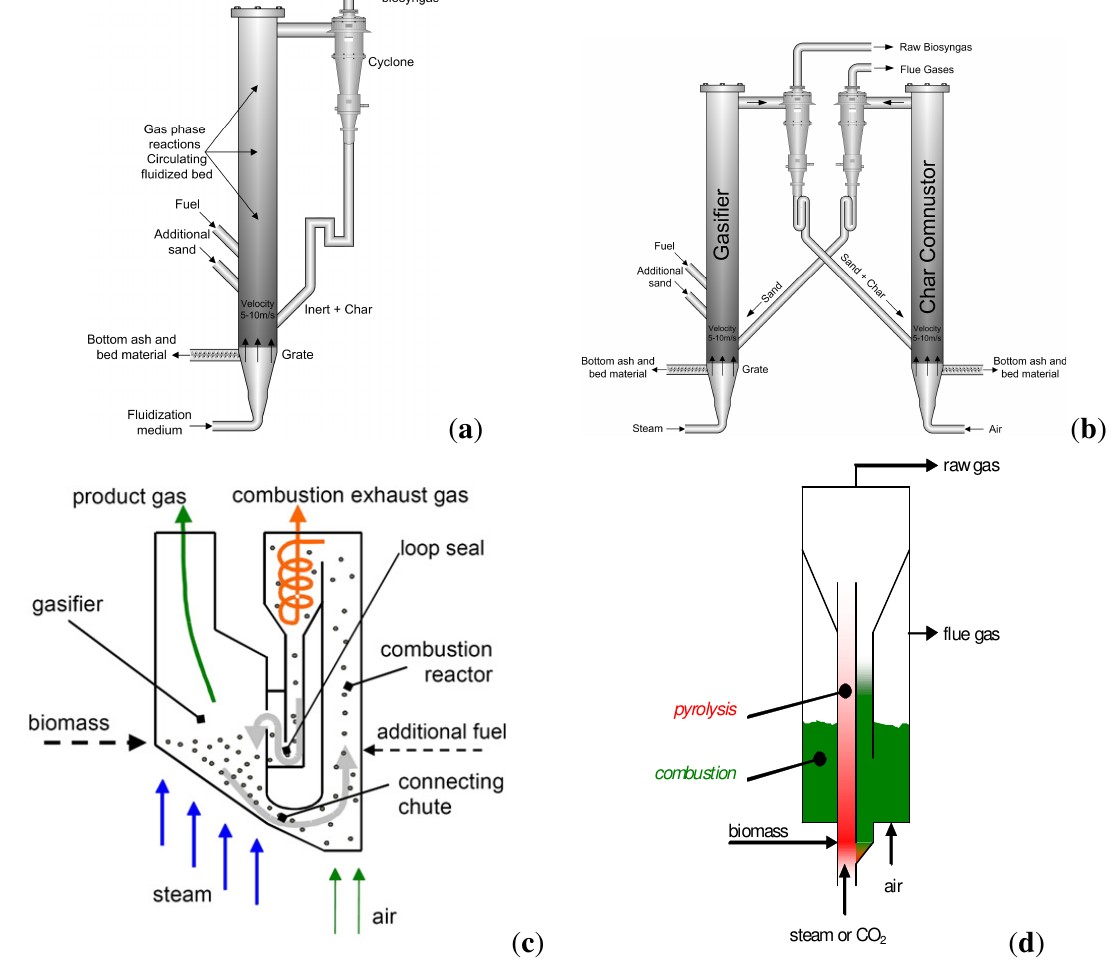
Figure 7 . Different CFB gasification concepts: ( a ) classical, directly heated [49]; ( b ) indirectly heated dual CFB, Battelle [49]; ( c ) indirectly heated FICFB, TU Vienna [50]; ( d ) indirectly heated Milena, ECN [51].